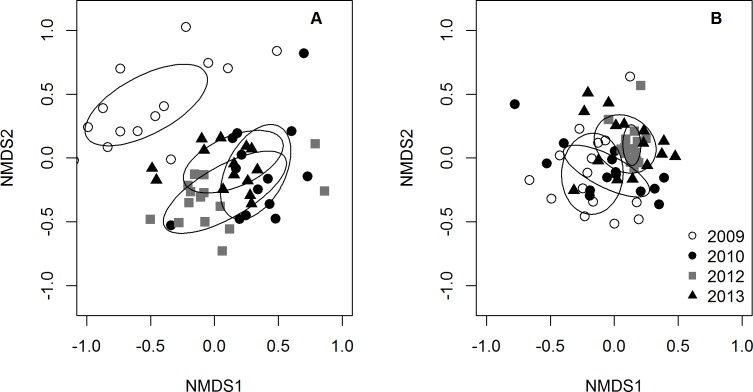
NMDS plots of small prey fish community composition.Community composition was visualized using (A) prey species abundance (density) and (B) prey species presence/absence. Each point represents the average community composition across all transects from each site for each year surveyed. Ellipses are standard deviations of the mean for each year. When using density data, 2009 is distinct from all other years (A) whereas there are no differences between years when using presence/absence data (B).